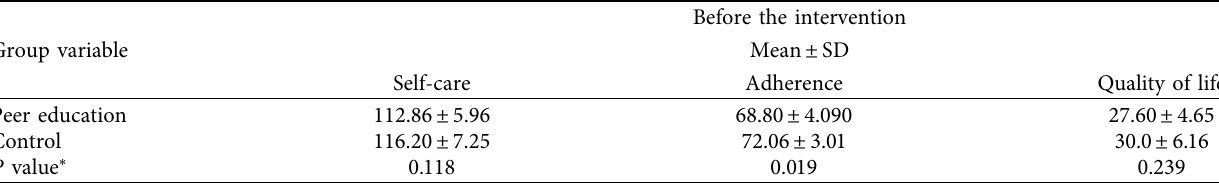
Table 2: Comparison of the two groups regarding the mean scores of self-care, adherence, and quality of life. Group variable